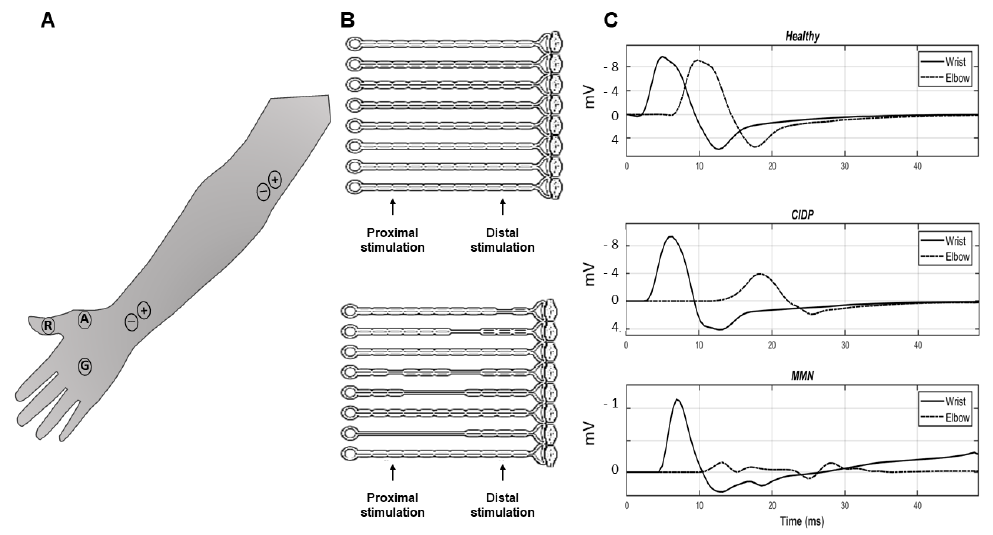
Figure 1. Motor nerve conduction study of the Median Thenar (MT) muscle: comparison between controls and patients with segmental demyelination. ( A ) Motor responses are recorded by surface electrodes (A and R) and the ground electrode G is used for reference. The nerve is depolarized via external stimulation at two distinct sites (proximal and distal pairs of electrodes for bipolar stimulation are indicated). ( B ) Model of conduction block: intact axons on top and multifocal demyelination on bottom, typical of acquired demyelinating neuropathies (e.g., CIDP and MMN). ( C ) Experimental signals recorded from the MT of different subjects: healthy (top row), CIDP (middle row) and MMN (bottom